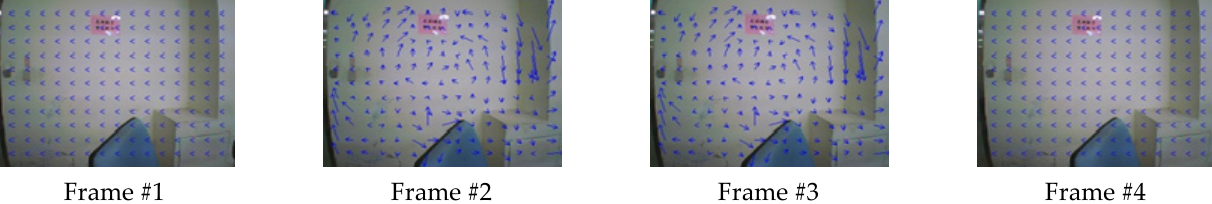
Figure 3. The blue arrows denote the estimated optical flow vectors when the camera moves to the wall. We quickly redraw points uniformly every three frames.